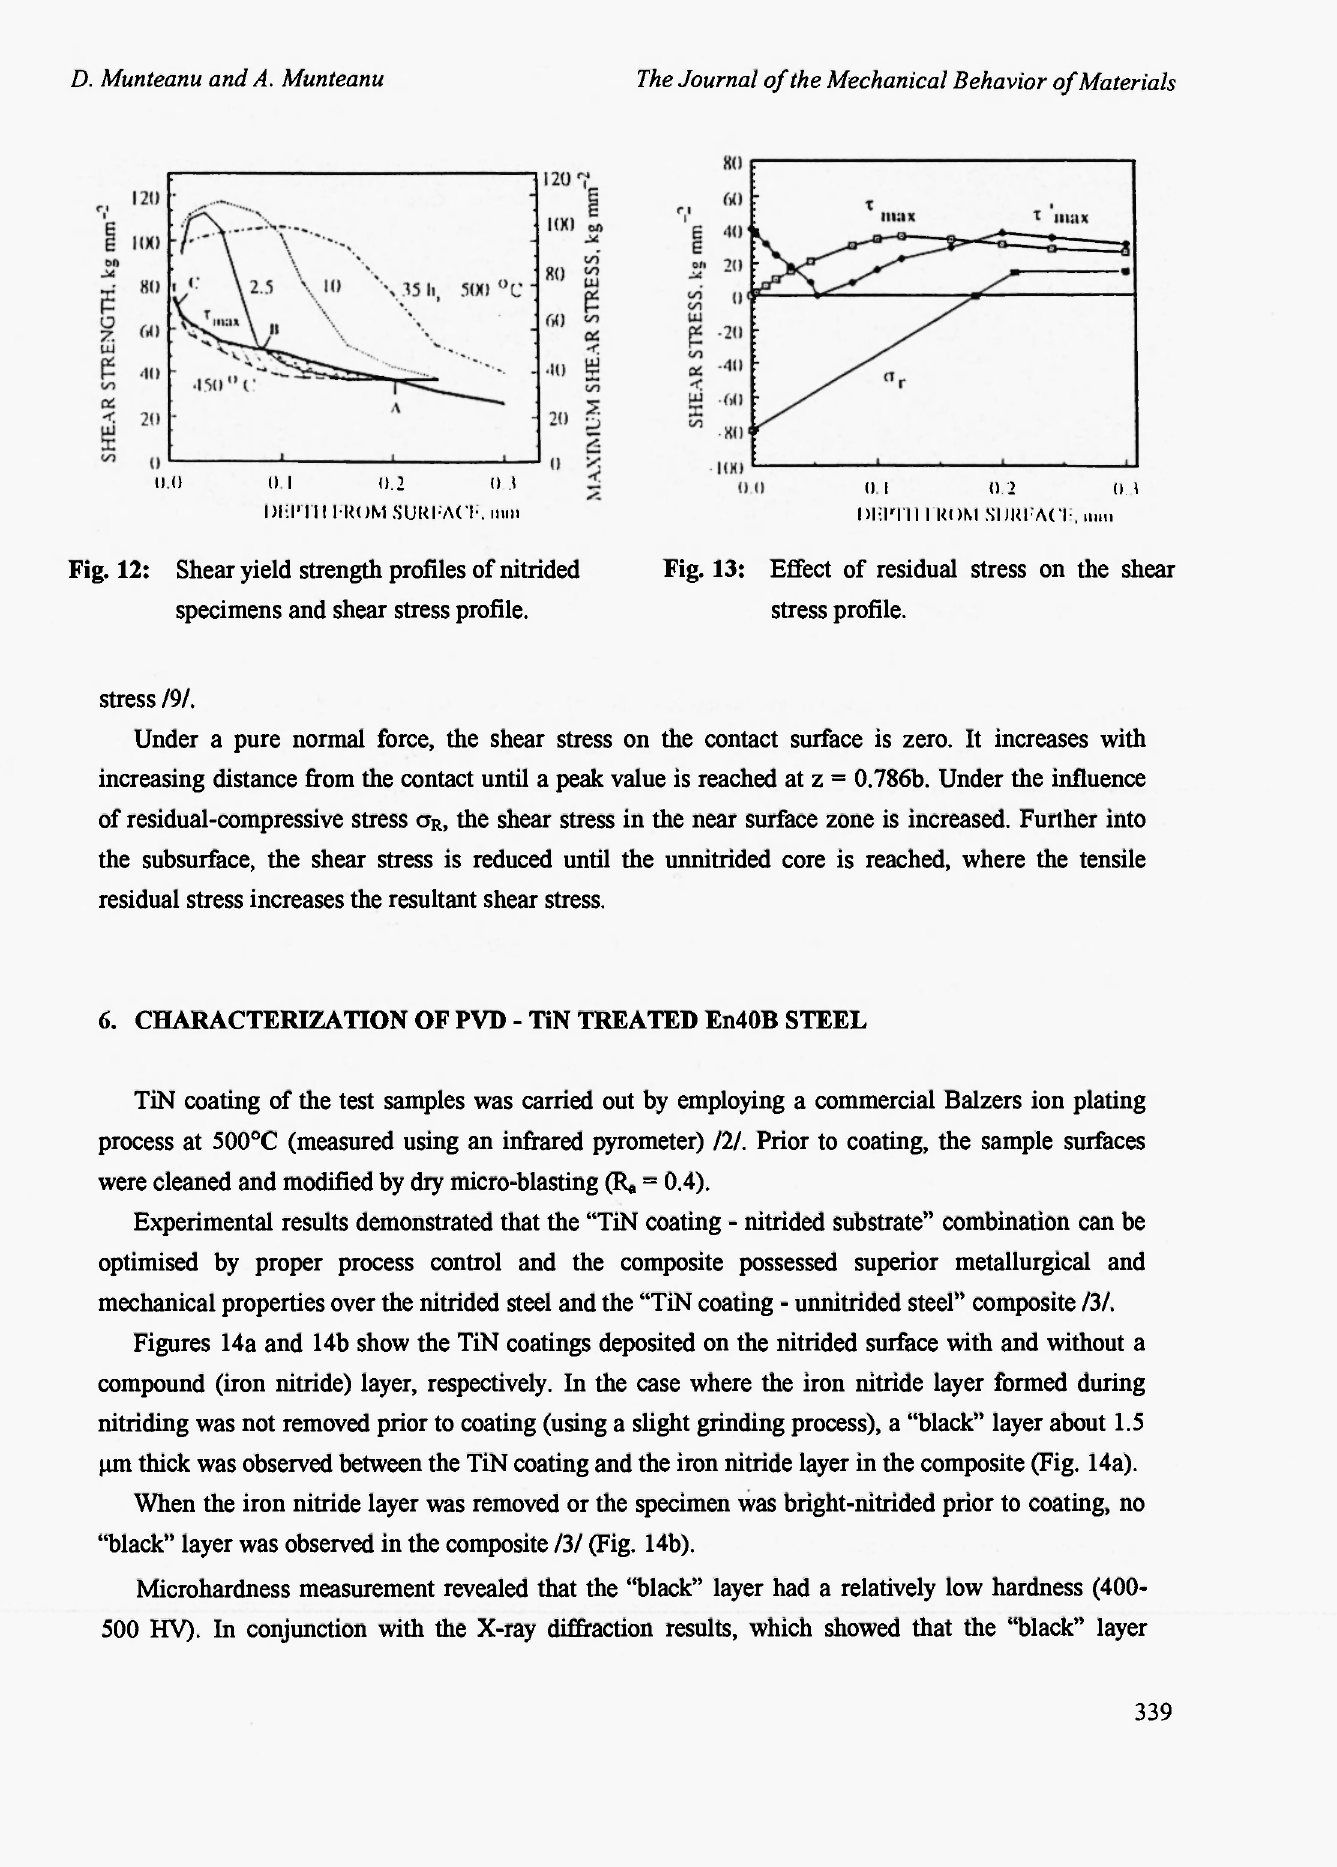
(II 0.2 (M Dlil'l'll II« >M SI)ΚΙ·"Λ( Ί-, mm Fig. 13: Effect of residual stress on the shear stress profile.